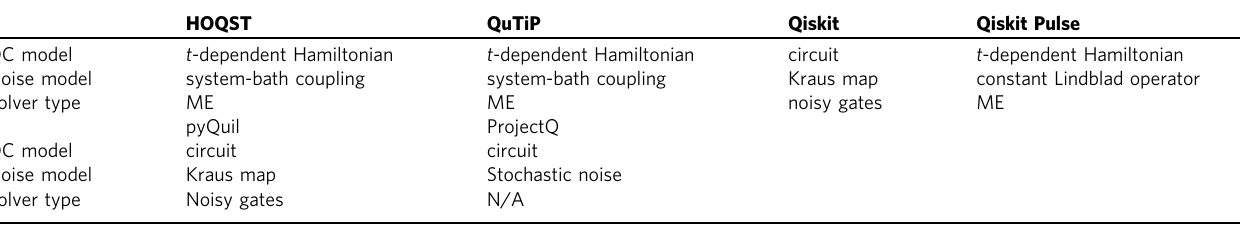
Table 1 Comparison chart for noise models and solver types adopted by different software